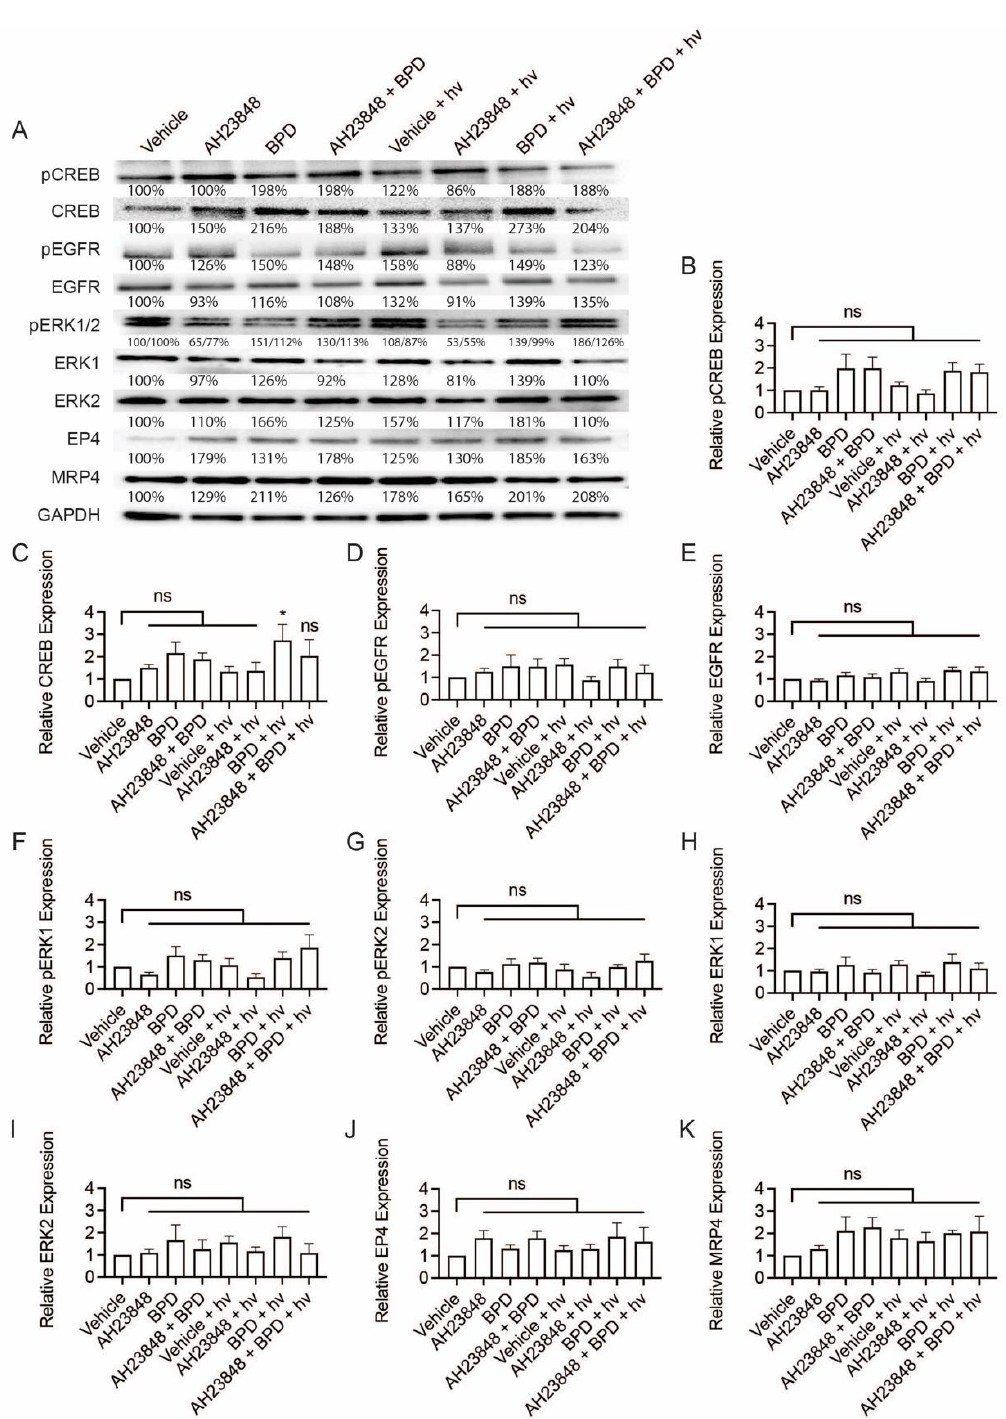
Figure 2. Western blot analysis of p-CREB, CREB, p-EGFR, EGFR, p-ERK1/2, ERK1, ERK2, EP4, and MRP4 in OVCAR-5 cells. Cells were treated with the indicated agents for 24 h, then light-activated (0.1 J/cm 2 , 10 mW/cm 2 ) or maintained in dark conditions. After 24 h, cells were agonized with EGF (50 ng/mL) and PGE2 (1 µM) for 10 min, then whole extracts were collected and analyzed using Western blot. ( A ) Representative Western blot images and ( B – K ) relative densitometric bar graphs of phosphorylated and total proteins were shown. Results are normalized to the vehicle control group. Statistical analysis was performed using a one-way ANOVA and post hoc Tukey’s test. Percentages below each band represent the average change in intensity relative to the vehicle control across all experiments. For pERK1 and pERK2 bands, the first number corresponds to pERK1, and the second number corresponds to pERK2. Error bars represent the standard error of the mean. * p ≤ 0.05; ns: nonsignificant. Original western blot images (Supplementary Figure